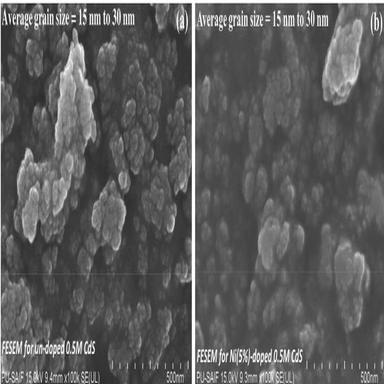
FE-SEM micrographs for (a) undoped, and (b) Ni(5%) doped 0.5M CdS NP.